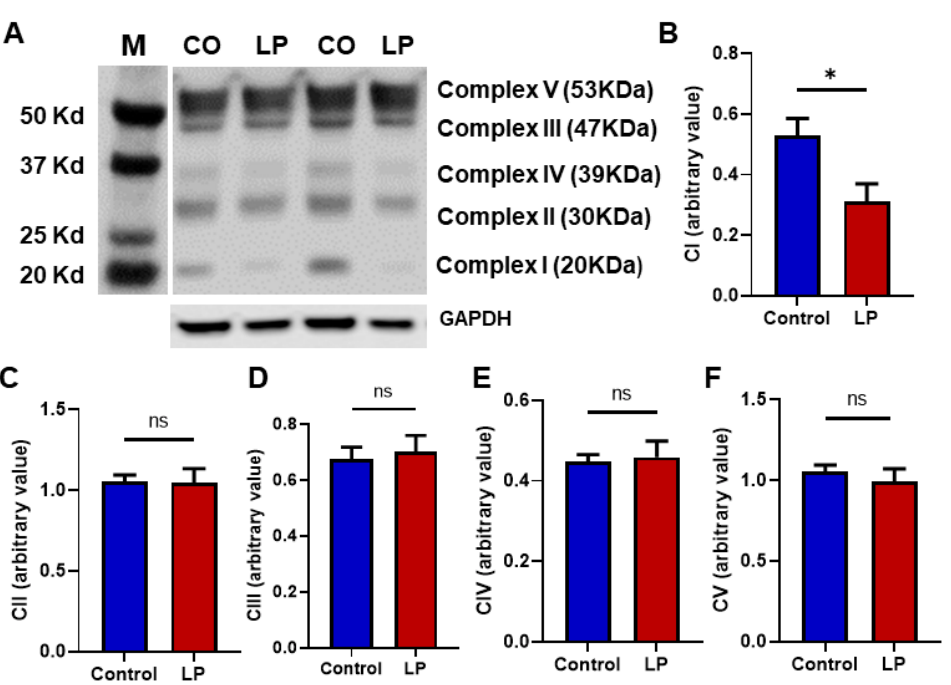
Figure 4. Effects of in utero LP programming on mitochondrial respiratory complex levels in the control vs. LP liver: ( A ) representative image of different mitochondrial complex protein content. ( B – F ) Fold-change of protein levels for the different subunits of mitochondrial complexes: ( B ) Com- plex I (CI, Ndufb8); ( C ) Complex II (CII, Sdhb); ( D ) Complex III (CIII, Uqccrc2); ( E ) Complex IV (CIV, mtCo); Complex V (CV, ATP5a). GAPDH (Glyceraldehyde-3-phosphate dehydrogenase) is used as a loading control for Western blots, and its values are used for normalization. Data represent mean ± SEM (* p < 0.05, ns—not significant); n = 6.